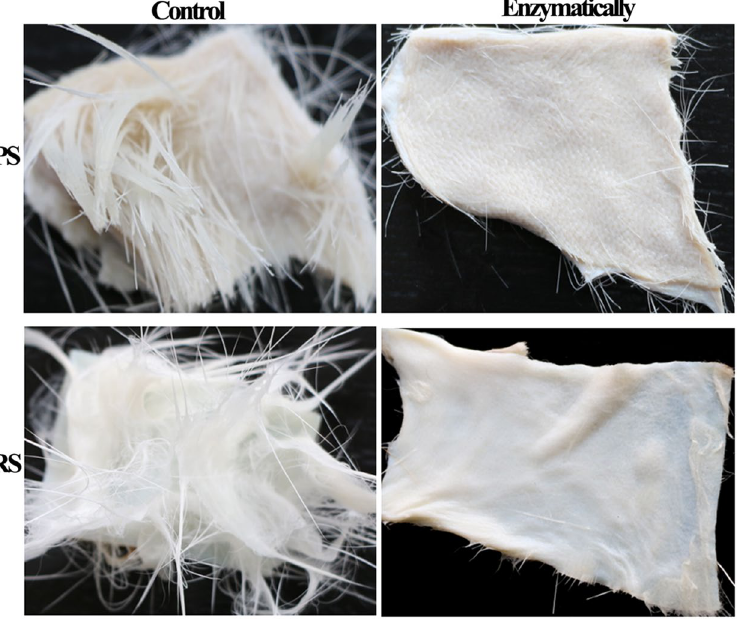
Figure 9. Enzymatic dehairing of pig and rabbit skins by crude AprA-PPC. PS represents pigskins, whereas RS represents rabbit skin. The dehairing treatment was performed at 40 °C for 8